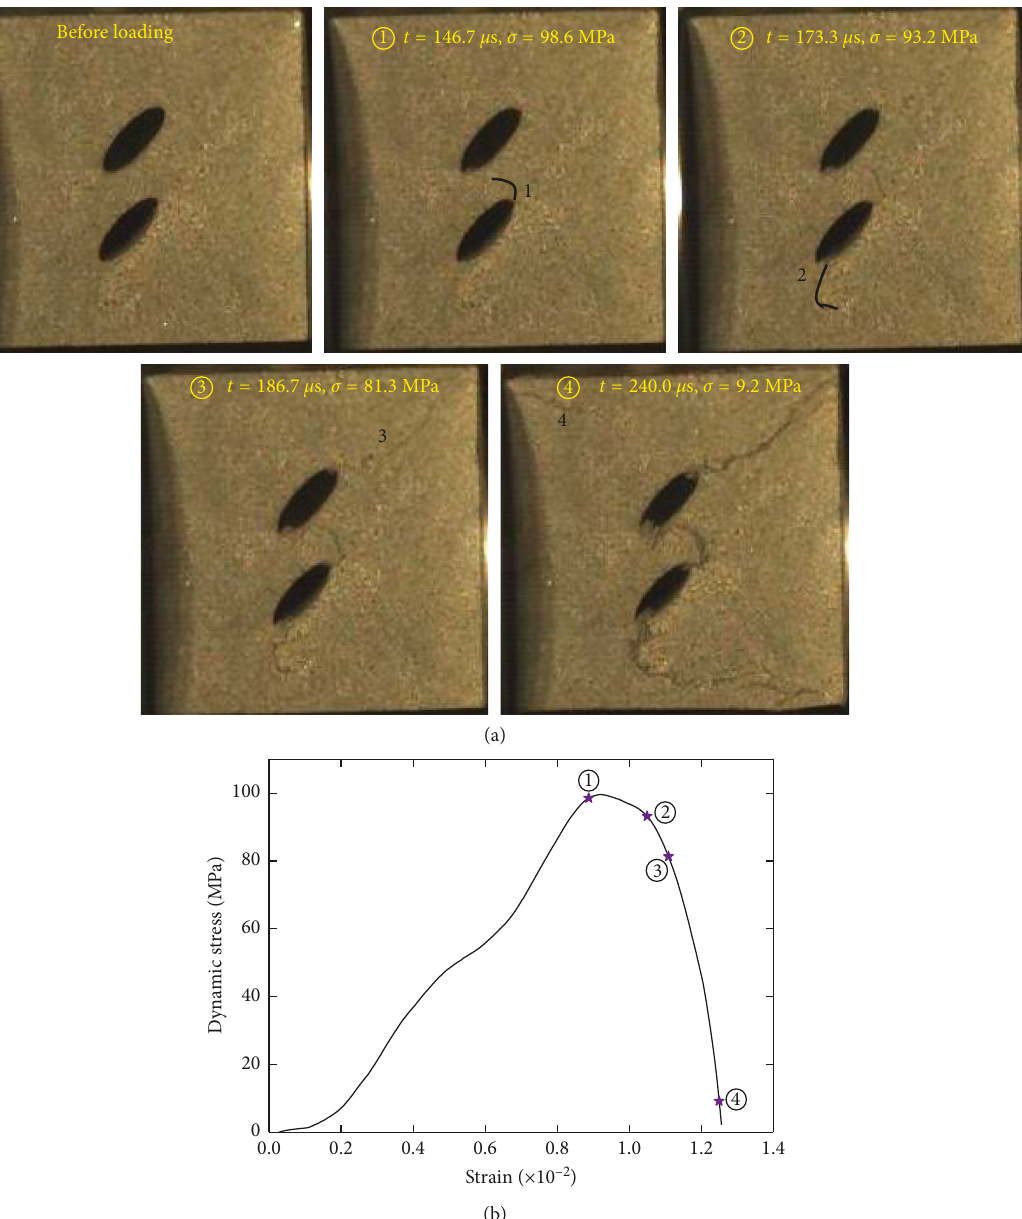
Figure 20: Fracturing process of type V mode with its corresponding dynamic stress-strain curve ( α